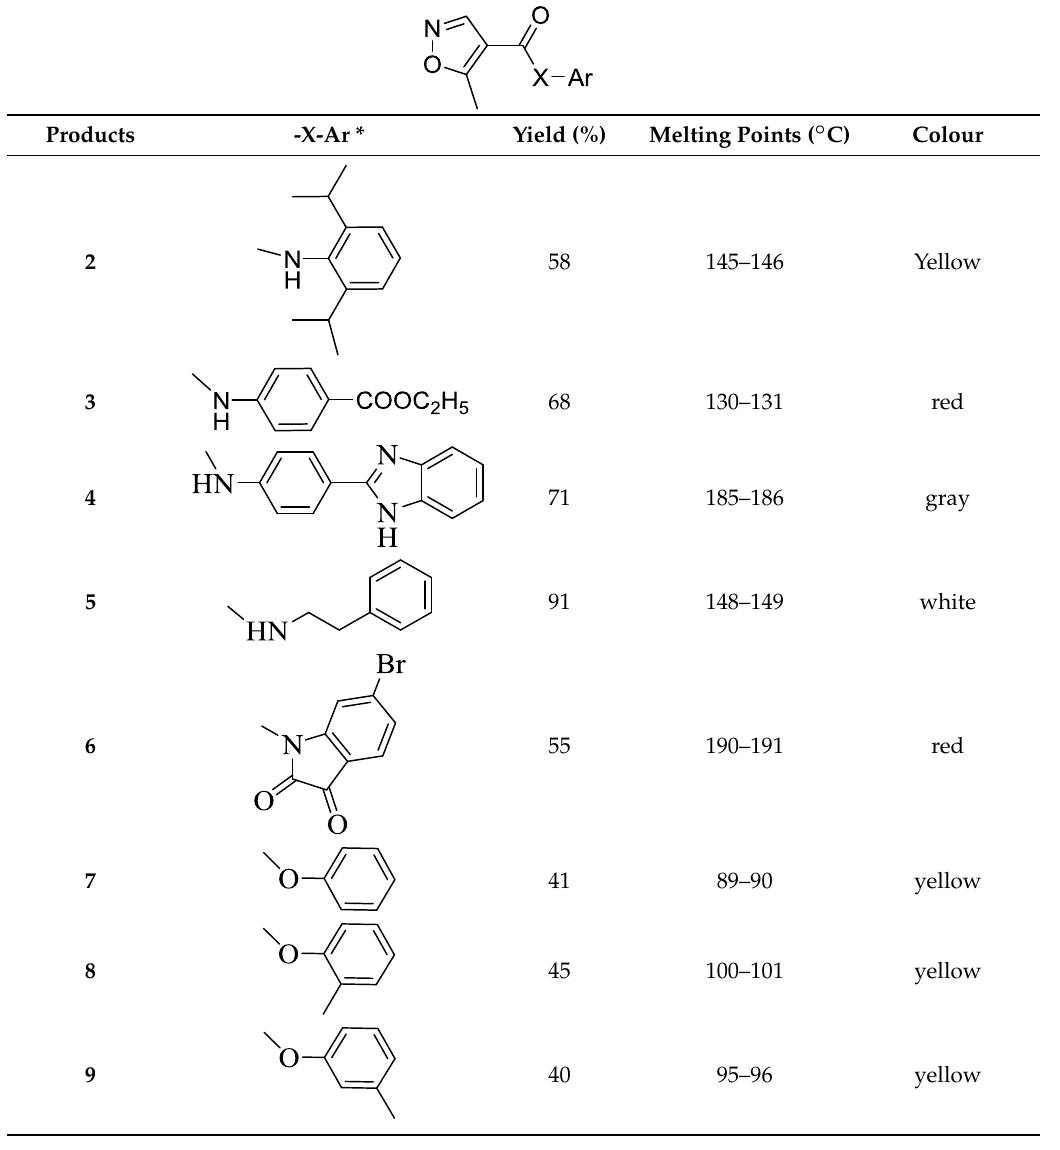
Table 1. Synthesis of 5-methyl-4-isoxazole derivatives ( 2 – 13 ).